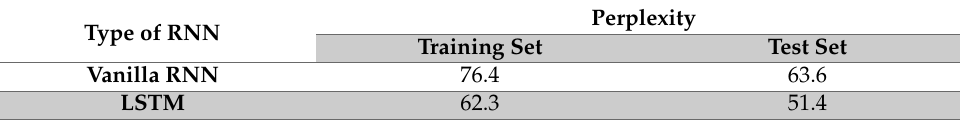
Table 4. Perplexity of vanilla RNN and LSTM language models.